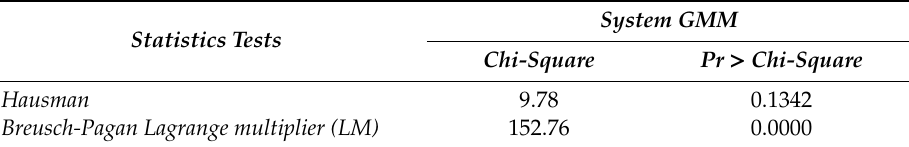
Table 7. Statistics Test of the Target Adjustment Model.